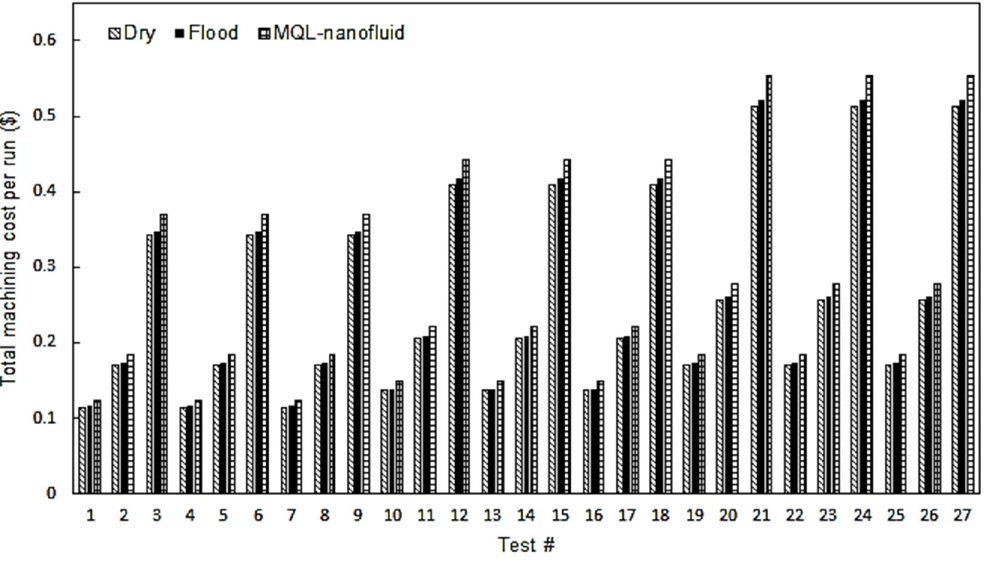
Figure 7. The total machining cost results.